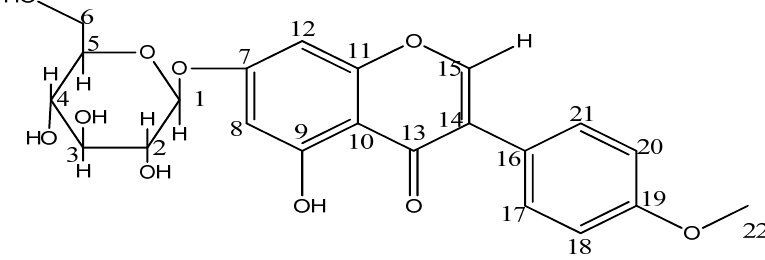
Figure 15. Structure for isoflavonoid glucosides isolated from the bark of gorse.